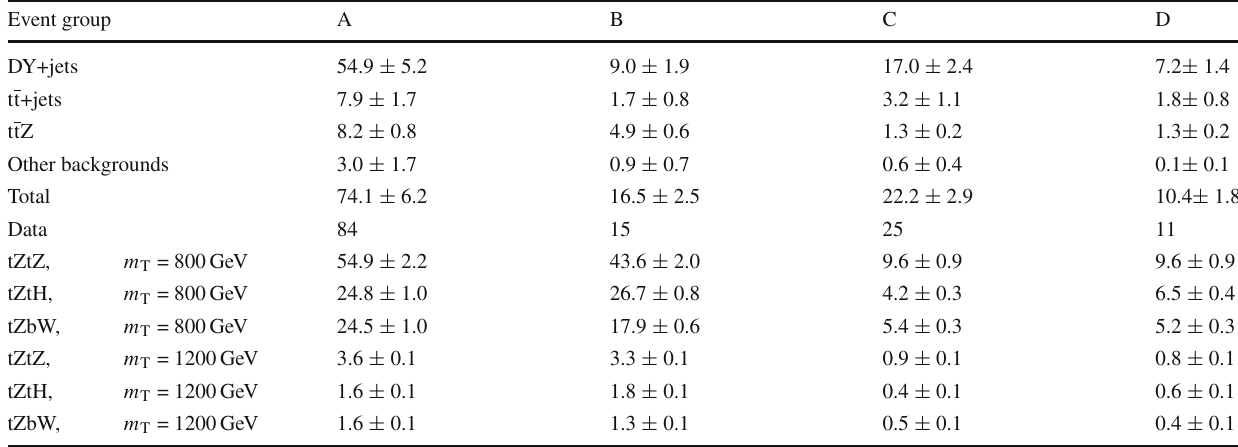
Table 6 The number of observed events and the predicted number of SM background events in the TT search using Z → e + e − channel in the four event groups. The expected numbers of signal events for T quark masses of 800 and 1200GeV for three different decay scenar- ios with assumed branching fractions B ( T → tZ ) = 100% (tZtZ) ,